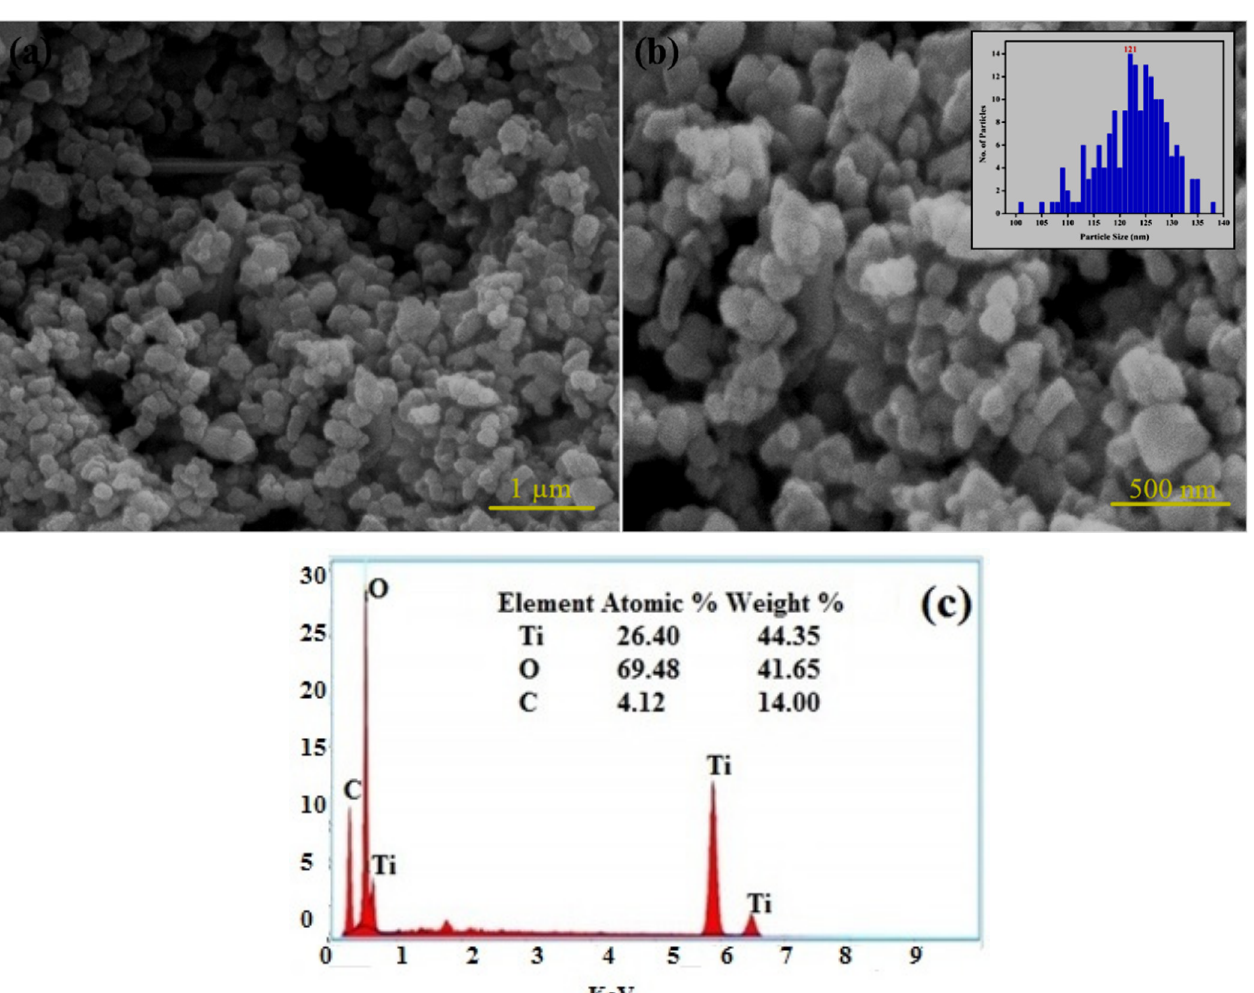
Figure 2. SEM–EDX analysis of TiO 2 nanoparticles: ( a ) SEM image at 1 µM; ( b ) 500 nm; ( c ) EDX analysis.